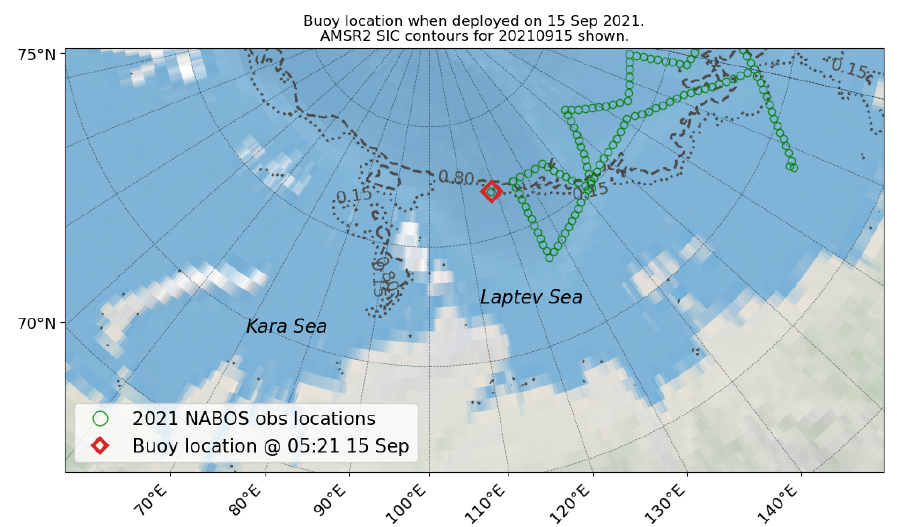
Figure 6. Zeni-v2021 and SPOT-1386 deployment location on 15 September 2021. The 2021 NA- BOS observation locations also shown in green markers and AMSR2-derived 0.15 and 0.80 Sea Ice Concentration (SIC) contours for the same day are